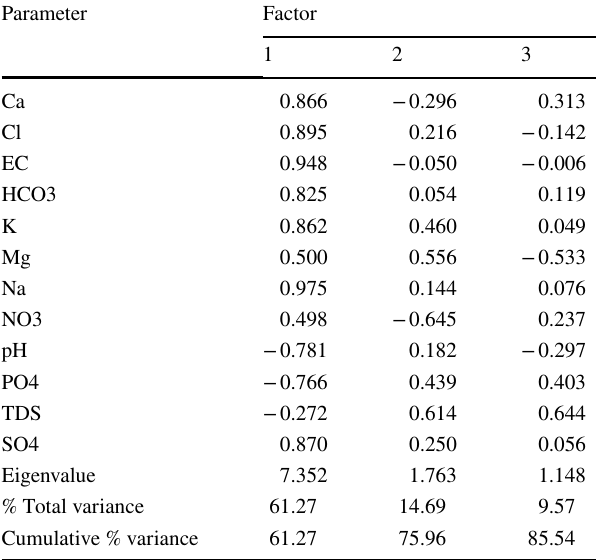
Table 5 Rotated factor loadings for groundwater samples in station of Bredeah Parameter